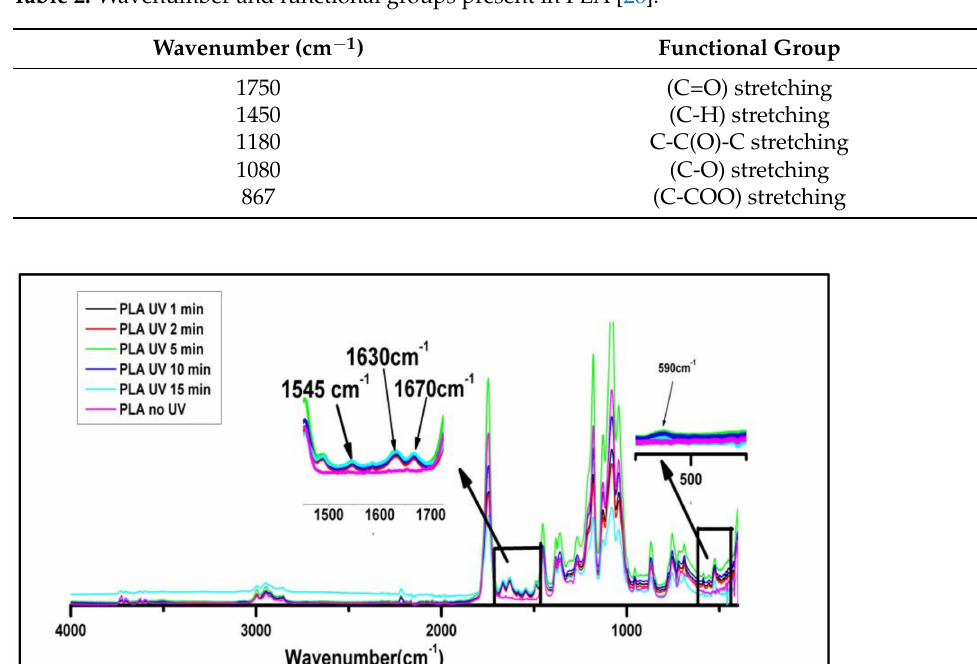
Table 2. Wavenumber and functional groups present in PLA [26].